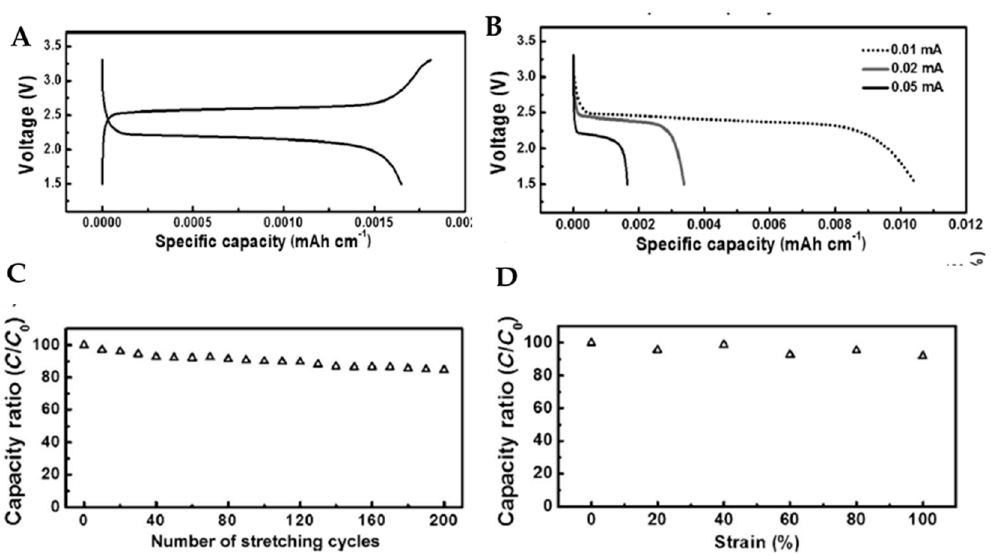
Figure 8. Electrochemical performance of the wire-shaped full cell with a length of 1 cm. ( A ) Galvanostatic charge and discharge curves at 0.05 mA. ( B ) Discharge profiles at different currents. ( C ) Dependence of the specific capacity on the strain. ( D ) Dependence of the specific capacity on the number of stretching cycles with a strain of 100%. C0 and C correspond to the specific capacities before and after stretch. Adapted with permission from [99]. Copy right (2014) Wiley ‐ VCH Verlag GmbH and Co. KGaA, Weinheim.